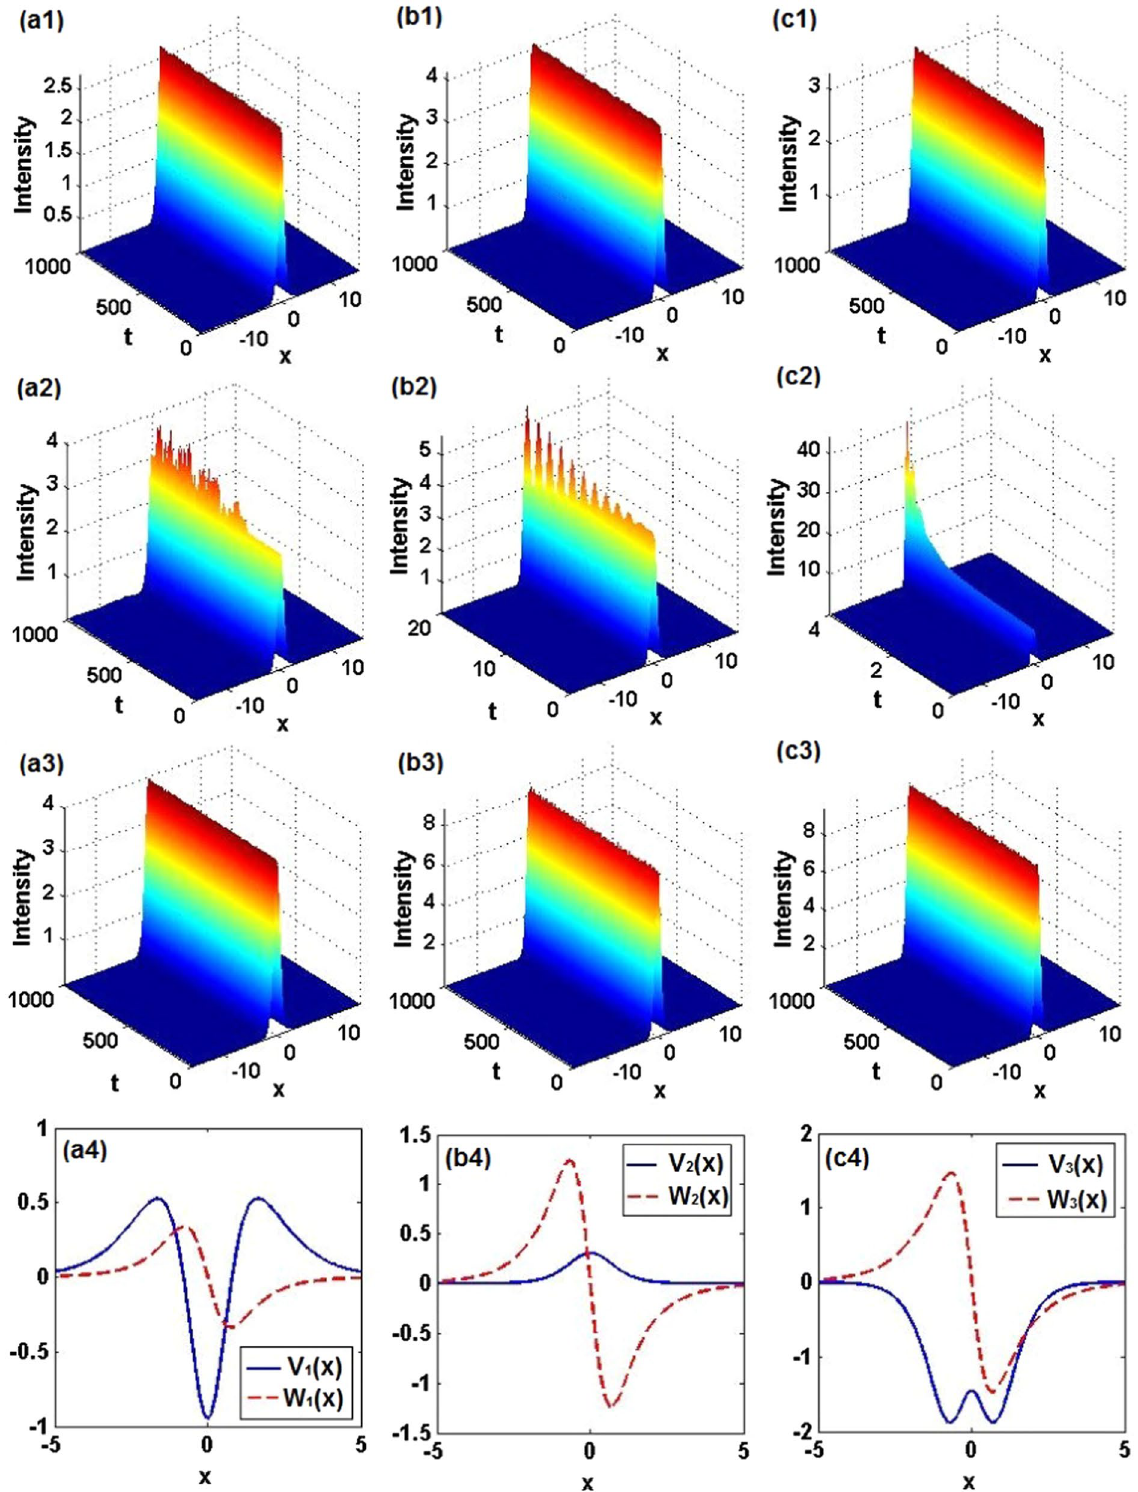
Figure 3. Propagation dynamics of exact nonlinear localized modes (6). ( a1